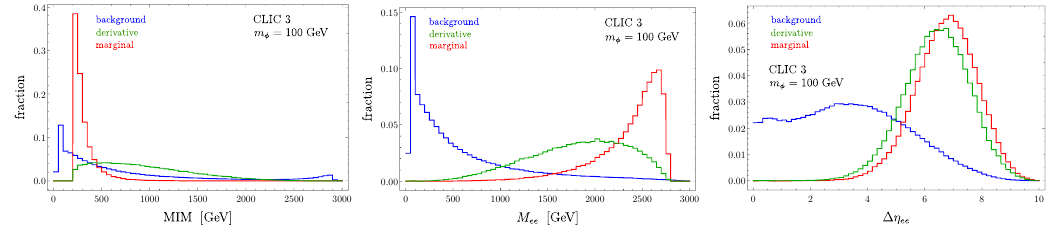
Figure 4: Normalized distributions for the signals and background at CLIC with (cid:112) s = 3 TeV. The φ mass is set to 100 GeV.